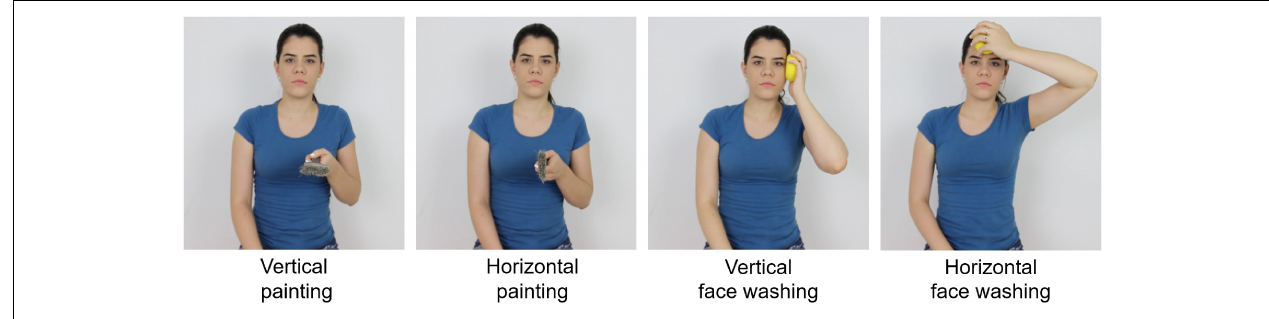
FIGURE 1 | Instructed action stimuli types.